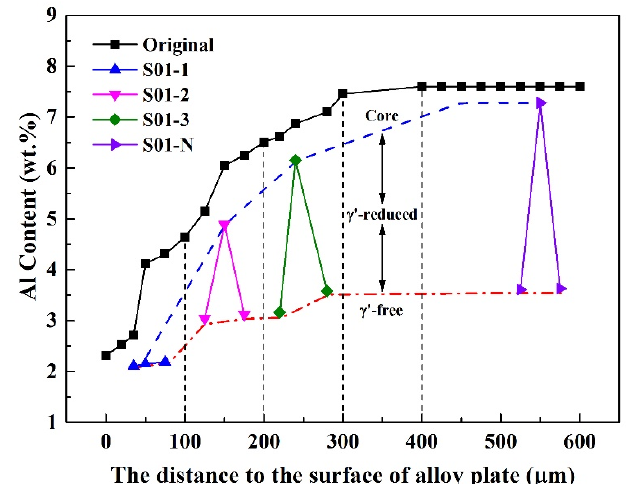
Figure 10. Variation of Al content in the thin specimens (thickness of 0.1 mm) with different original Al contents after 100 h of isothermal oxidation at 1100 °C. The values measured in the core and at the γ ’ − free/ γ ’ − reduced interface are plotted in accordance with the distances to the surface of alloy plate, from which the specimens were cut. The vertical dashed lines are plotted to distinguish the sampling areas with different original Al contents. The original Al contents in the alloy plate as a function of distance are also plotted for comparison.